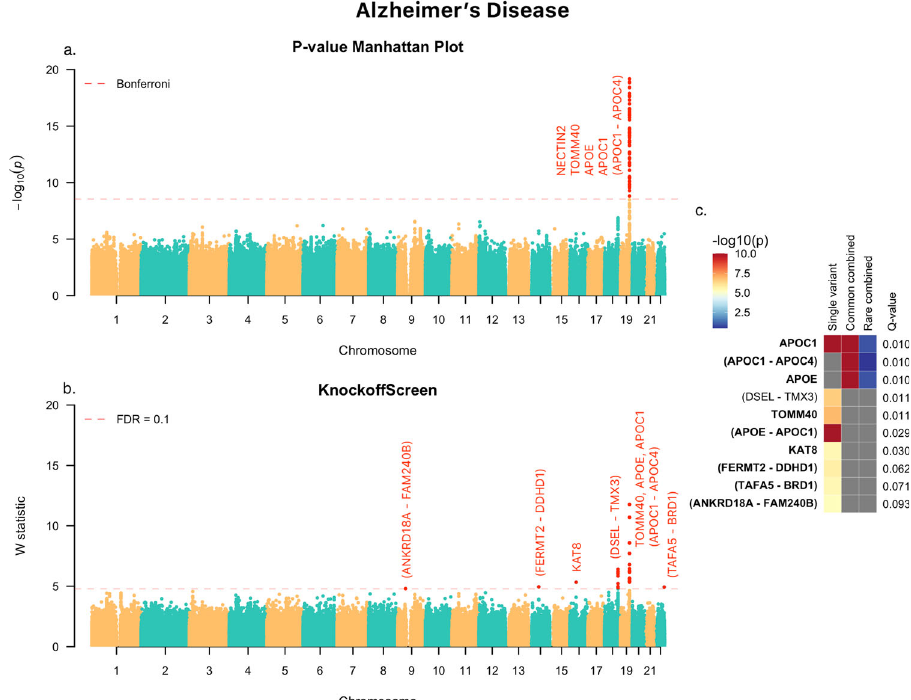
Fig. 6 KnockoffScreen application to the Alzheimer ’ s Disease Sequencing Project (ADSP) data to identify variants associated with the Alzheimer ’ s Disease. a Manhattan plot of p -values (truncated at 10 (cid:2) 20 for clear visualization) from the conventional association testing with Bonferroni adjustment ( p < 0 : 05/number of tested windows) for FWER control. b Manhattan plot of KnockoffScreen with target FDR at 0.1. c heatmap that shows strati fi ed p - values (truncated at 10 (cid:2) 10 for clear visualization) of all loci passing the FDR = 0.1 threshold, and the corresponding Q-values that already incorporate correction for multiple testing. The loci are shown in descending order of the knockoff statistics. For each locus, the p -values of the top associated single variant and/or window are shown indicating whether the signal comes from a single variant, a combined effect of common variants or a combined effect of rare variants. The names of those genes previously implicated by GWAS studies are shown in bold (names were just used to label the region and may not represent causative gene in the region). Source data are provided as a Source Data fi